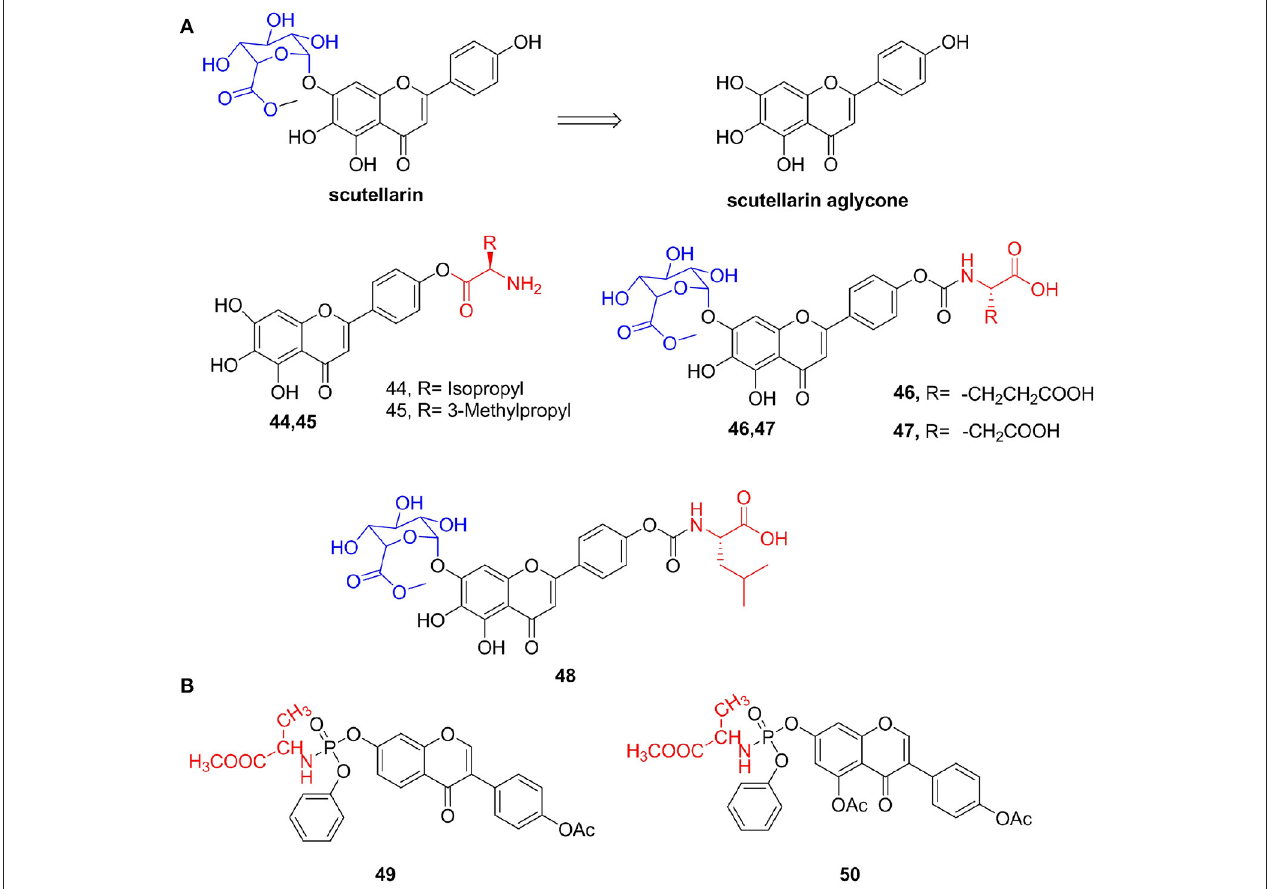
FIGURE 6 | (A) Scutellarin amino acid derivatives. (B) Isoflavone amino acid